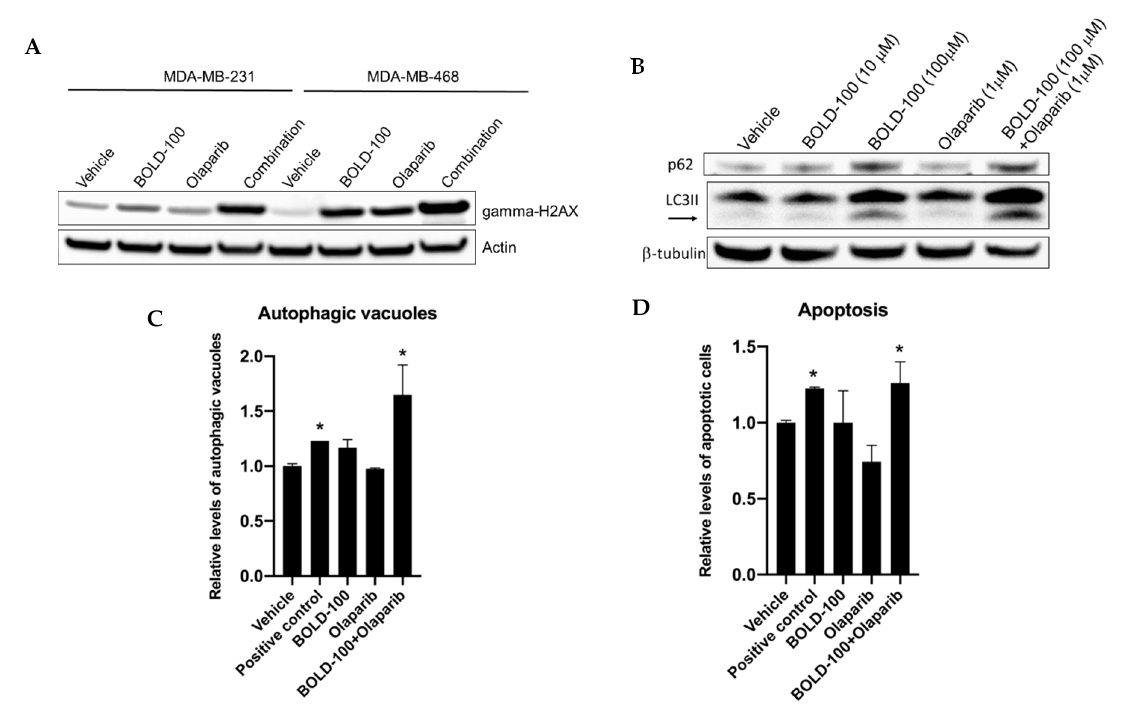
Figure 6. Combination of BOLD-100 and olaparib induces γ H2AX and cell death in TNBC cells. ( A ) Increased gamma-H2AX protein levels were detected by Western blotting in MDA-MB-231 and MDA-MB-468 cells following treatment with both BOLD-100 and olaparib compared with vehicle control for 72 h. Actin was used as a loading control. ( B ) Western blot analysis in MDA-MB-231 cells treated with BOLD-100 (100 µ M) or BOLD-100 (100 µ M) + olaparib (1 µ M) showed increased LC3II (autophagosome marker) and p62 (marker of autophagy activity). β -tubulin was used as a loading control. For whole blots, see Figures S5 and S6. ( C ) Cyto-ID assay (Enzo, Farmingdale, NY, USA) was used to measure autophagic vacuoles in MDA-MB-231 cells using flow cytometry: vehicle alone, positive control (cells were serum deprived for 24 h), 100 µ M BOLD-100, olaparib (1 µ M) or the combination at 72 h. Significantly increased autophagic vacuoles were seen in cells treated with both BOLD-100 and olaparib. ANOVA, p < 0.001; * p < 0.001 for treatment versus vehicle. ( D ) Annexin V-FITC assay was used to measure apoptosis levels in MDA-MB-231 cells: vehicle alone, positive control (10 nM doxorubicin), 100 µ M BOLD-100, olaparib (1 µ M) or the combination at 72 h. ANOVA, p < 0.002; * p < 0.03 for treatment versus vehicle.